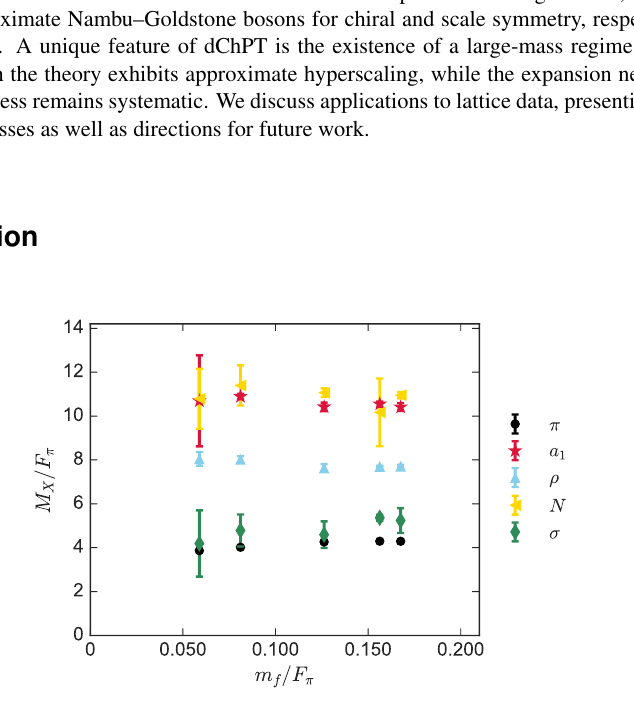
Figure 1. Hadron masses as a function of fermion mass, all in units of F ⇡ , in the SU(3) gauge theory with 8 fundamental flavors, from Ref.